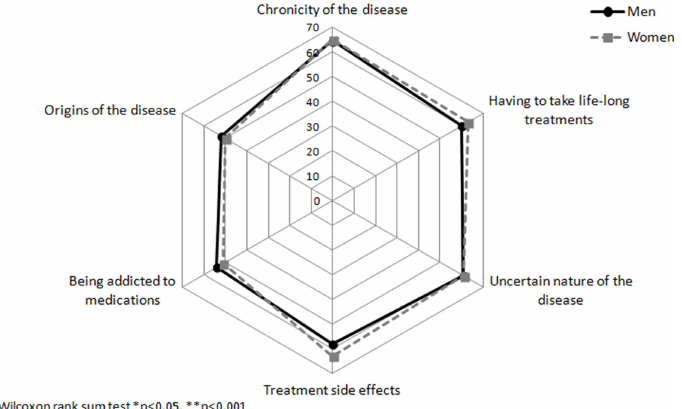
Fig 4. Median for individual concerns related to constraints and uncertainty according to